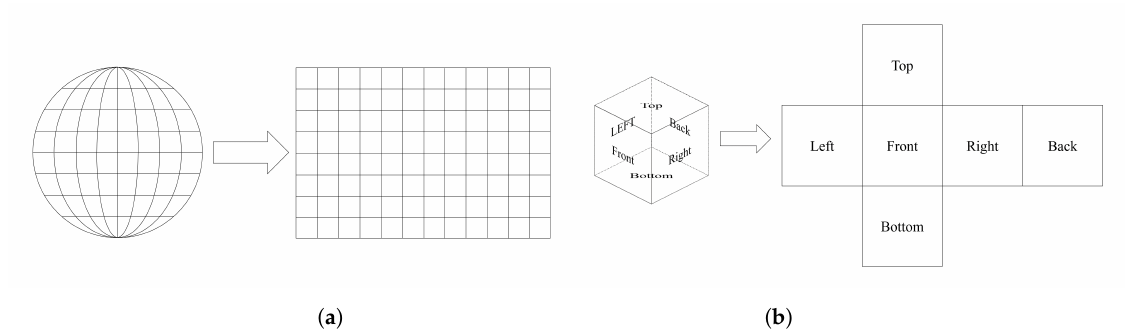
Figure 3. ( a ) Equirectangular projection; and ( b ) cubemap projection.